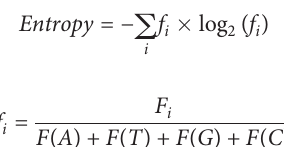
( Table S1 ). According to the whole coding sequences of 226 atg13 genes ( Table S1 ), the two phylogenetic trees were constructed by Maximum Composite Likelihood model with UPGMA statistical method at the nucleotide and amino acid levels,